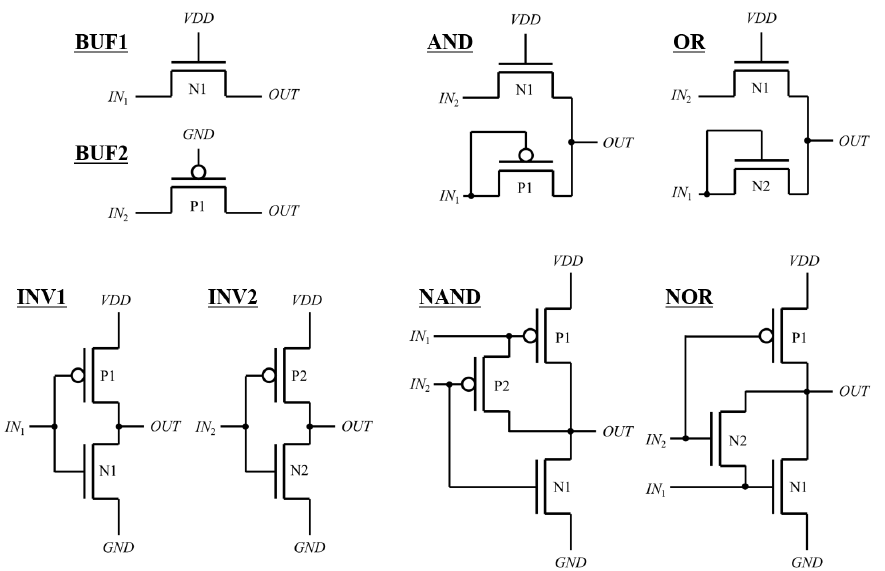
Figure 11. Working schematics extracted by GateRL for target logic gates.